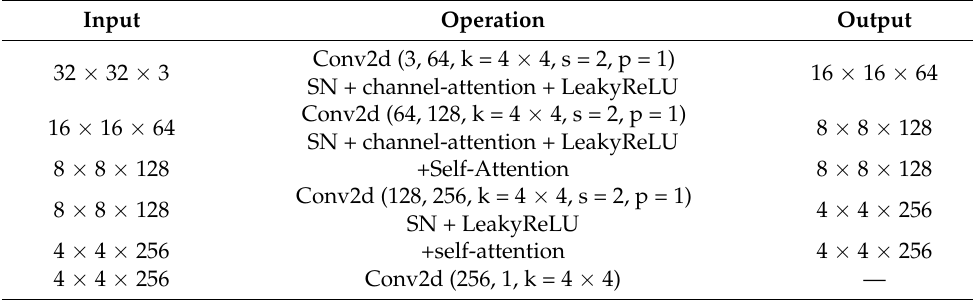
Table 4. The network structure of the discriminator in